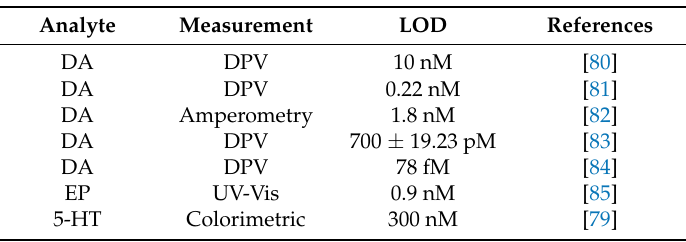
Table 3. Aptamer-based neurotransmitter